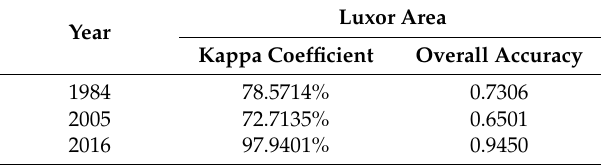
Table 2. Kappa Coefficient and overall accuracy of the regions of interest (ROIs)for each